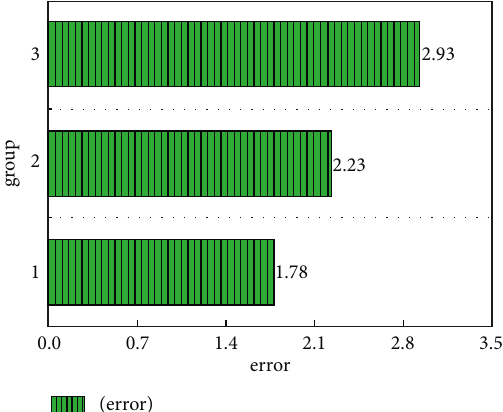
Figure 5: The prediction errors of musical innovative forms using LSTM